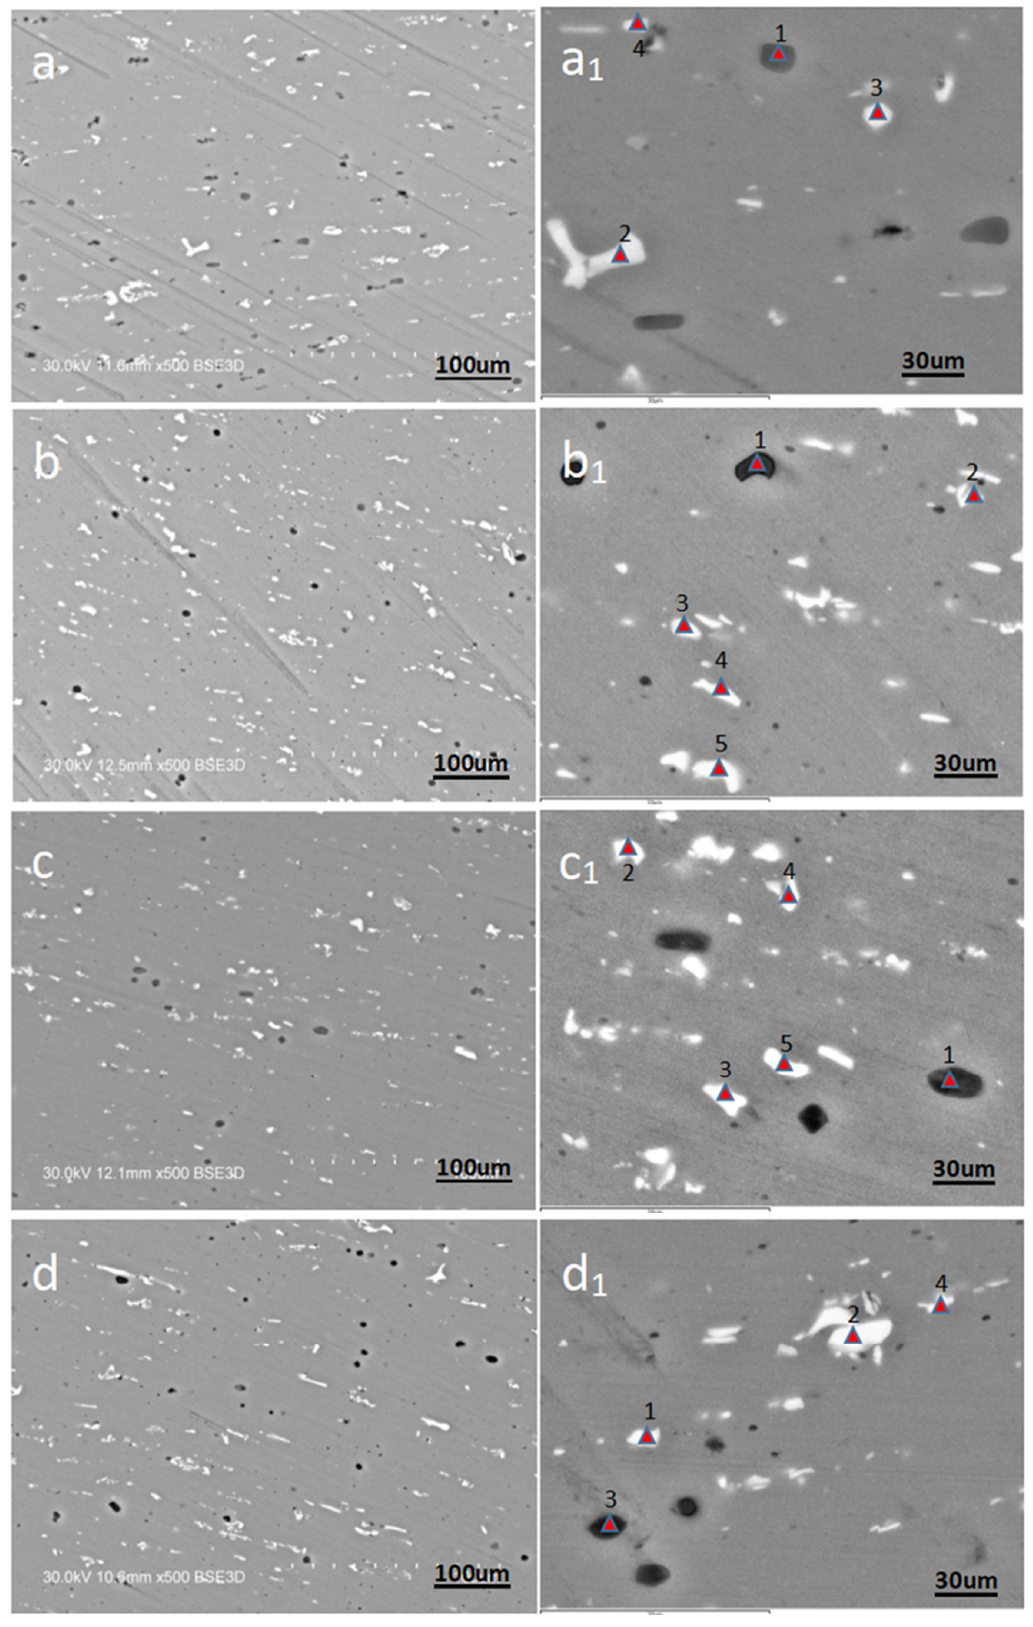
Figure 2. SEM microstructure of some samples (( a , a 1 ): 663.15 K, 0.001 S −1 ( b , b 1 ): 663.15 K, 10 S −1 ( c , c 1 ): 713.15 K, 1 S −1 ( d , d 1 ): 763.15 K, 1 S −1 ).